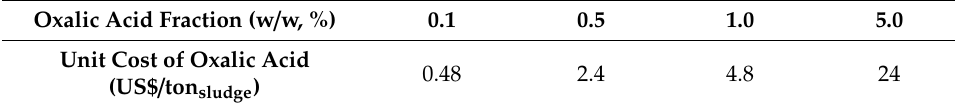
Table 3. The unit cost of oxalic acid with input in the HTC